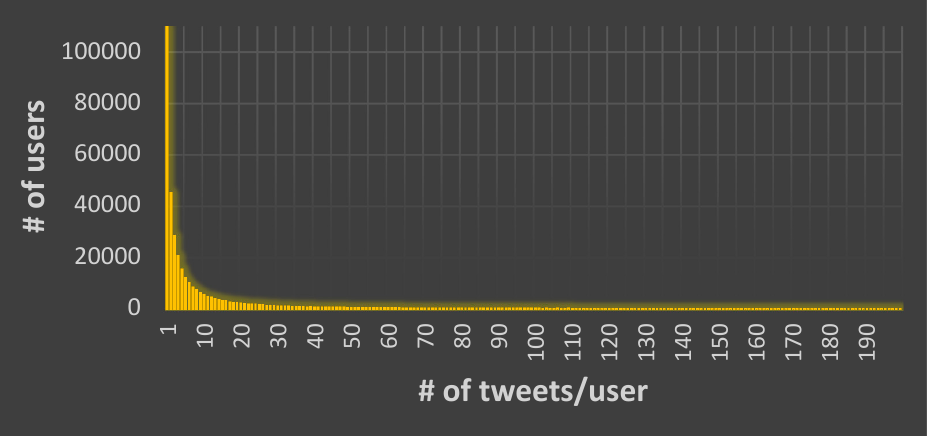
Figure 2. Frequency of tweet count per user.